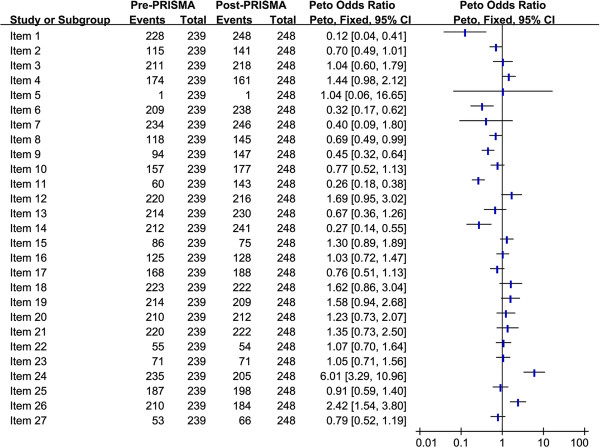
Comparison of pre-PRISMA and post-PRISMA periods for each PRISMA item.